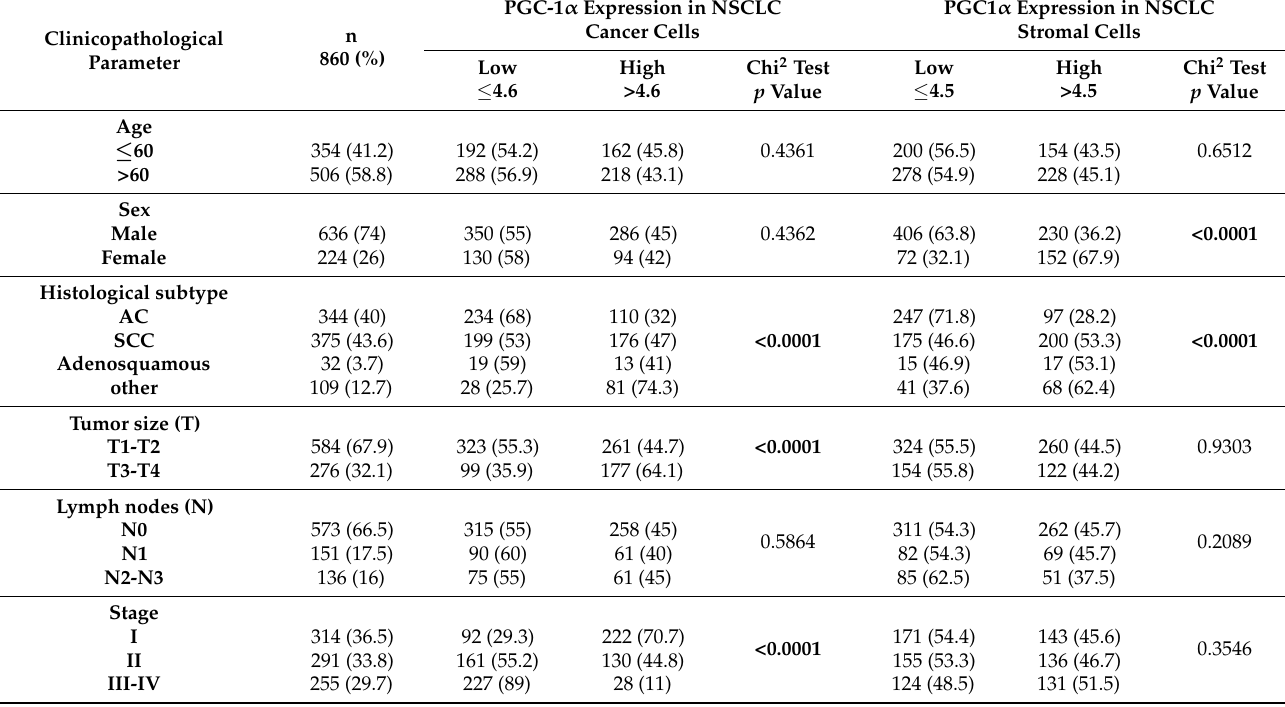
Figure 4. Kaplan–Meier survival curves show the prognostic impact of ERR α expression levels on overall survival (OS) in patients with NSCLC ( A ), AC ( D ), SCC ( G ). Kaplan–Meier survival curves show the prognostic impact of PGC-1 α expression levels in cancer cells on overall survival (OS) in patients with NSCLC ( B ), AC ( E ), SCC ( H ). Kaplan–Meier survival curves show the prognostic impact of PGC-1 α expression levels in stromal cells on overall survival (OS) in patients with NSCLC ( C ), AC ( F ), SCC ( I ). Patients were grouped according to the median value of expression levels. Table 3. Clinicopathological characteristics of patients with non-small cell lung cancer (NSCLC) related to low and high expression of PGC-1 α (Chi 2 test analysis), significance in bold.